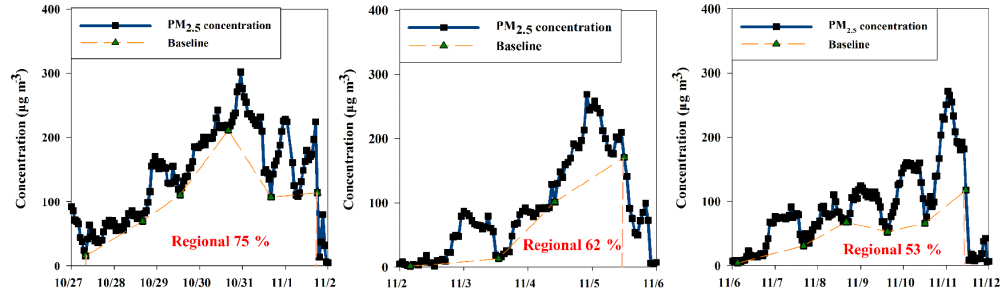
Figure 6. Regional and local components of the three episodes at the Liulihe site.